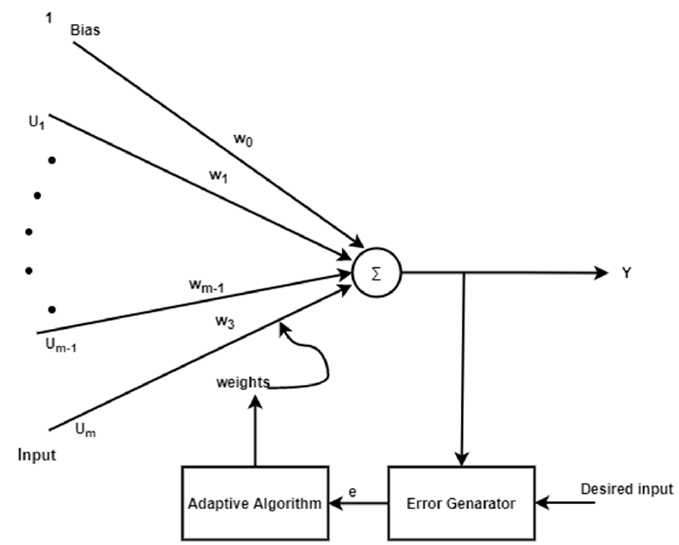
Figure 1. Linear neurons with m input.